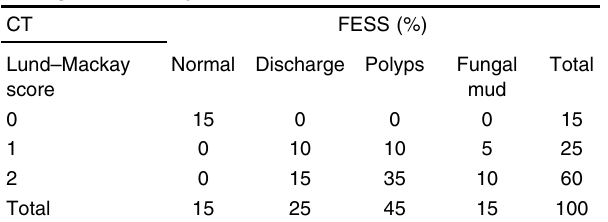
CT, computed tomography; FESS, functional endoscopic sinus